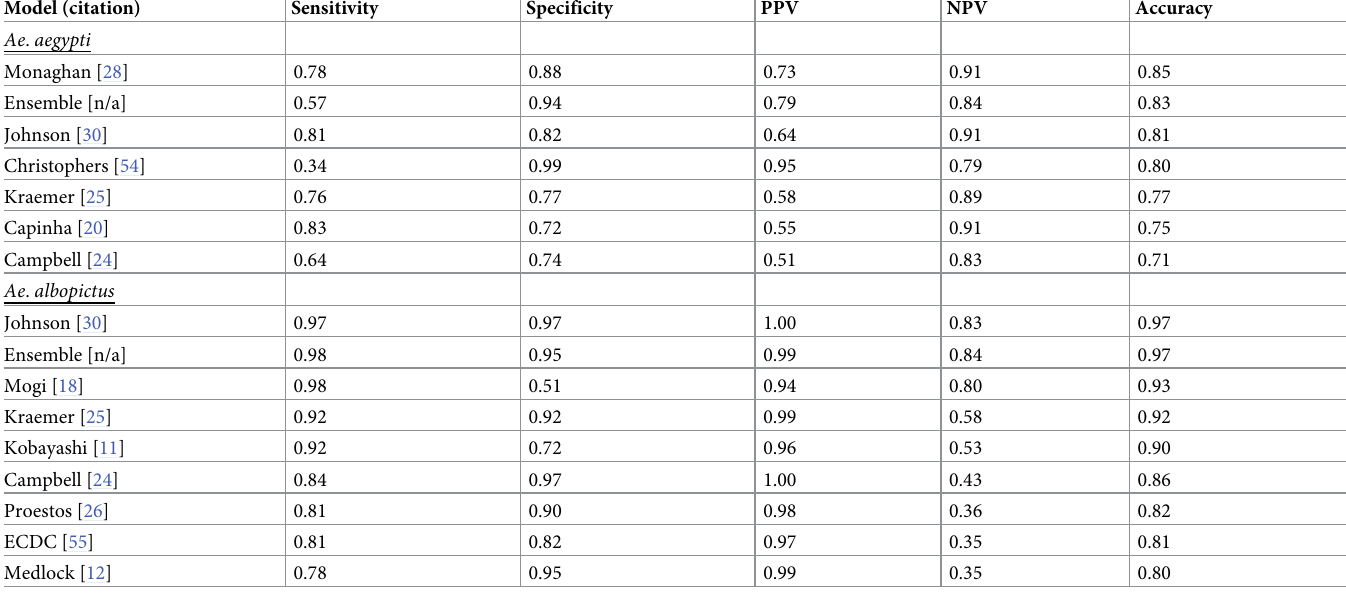
Table 2. Testing data fit statistics for the dichotomized base and ensemble models. Model